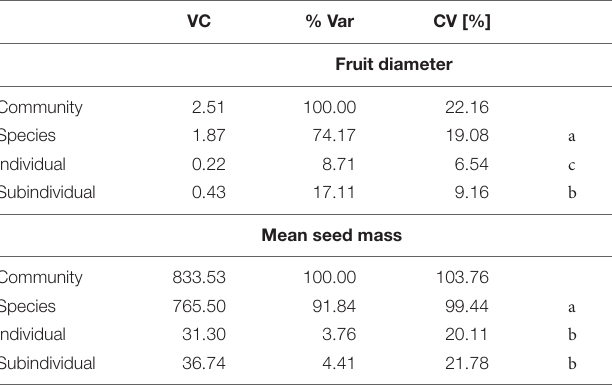
TABLE 1 | Analyses of variance components of fruit diameter and mean seed mass per fruit across nine fleshy-fruited plant species in Białowie˙za Forest,